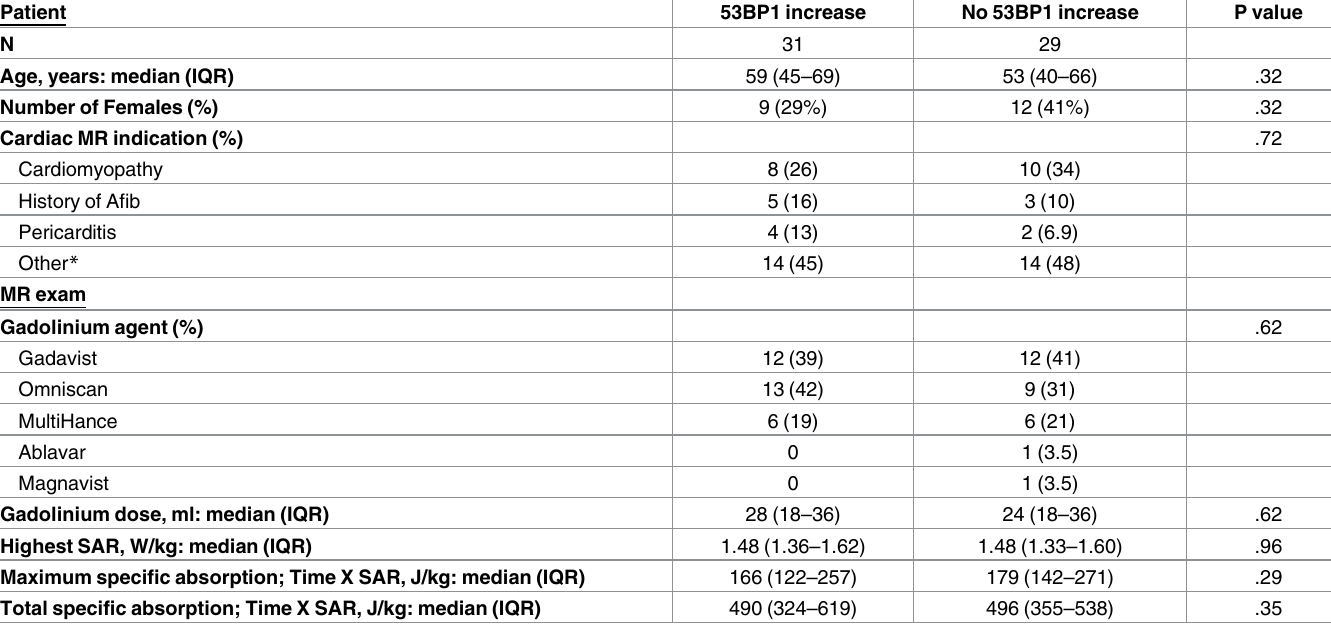
Table 4. Characteristics of patients with > 10% increasein